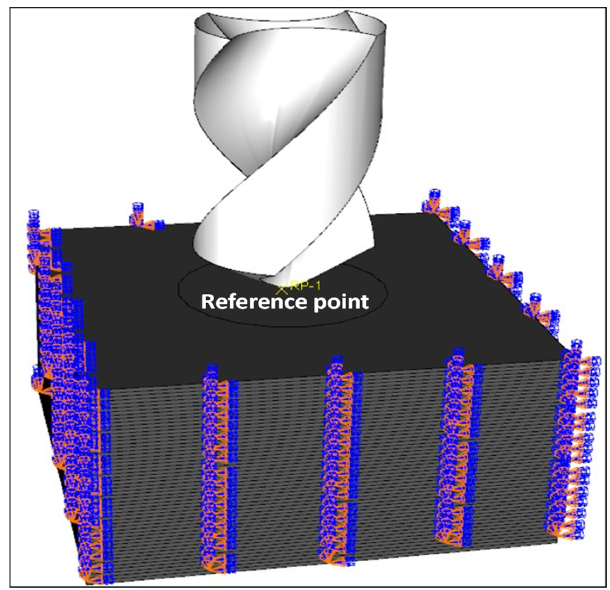
Figure 1. Drill-bit and workpiece along with the boundary conditions.